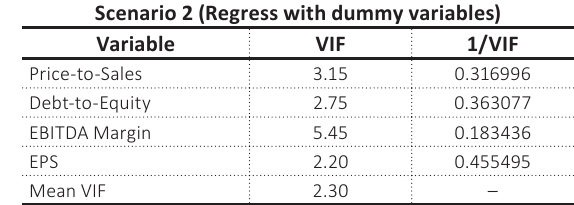
Table 3. Variation Inflation Factors of the variables Scenario 1 (Regress without dummy